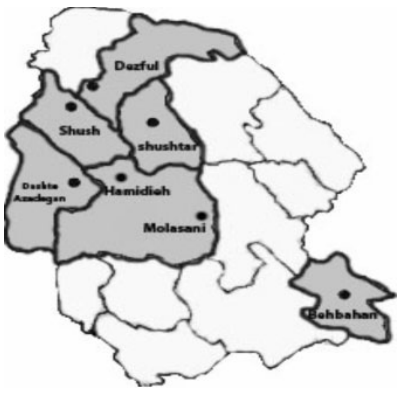
Figure 1. Geographical location of seven sampling regions in Khuzestan province.